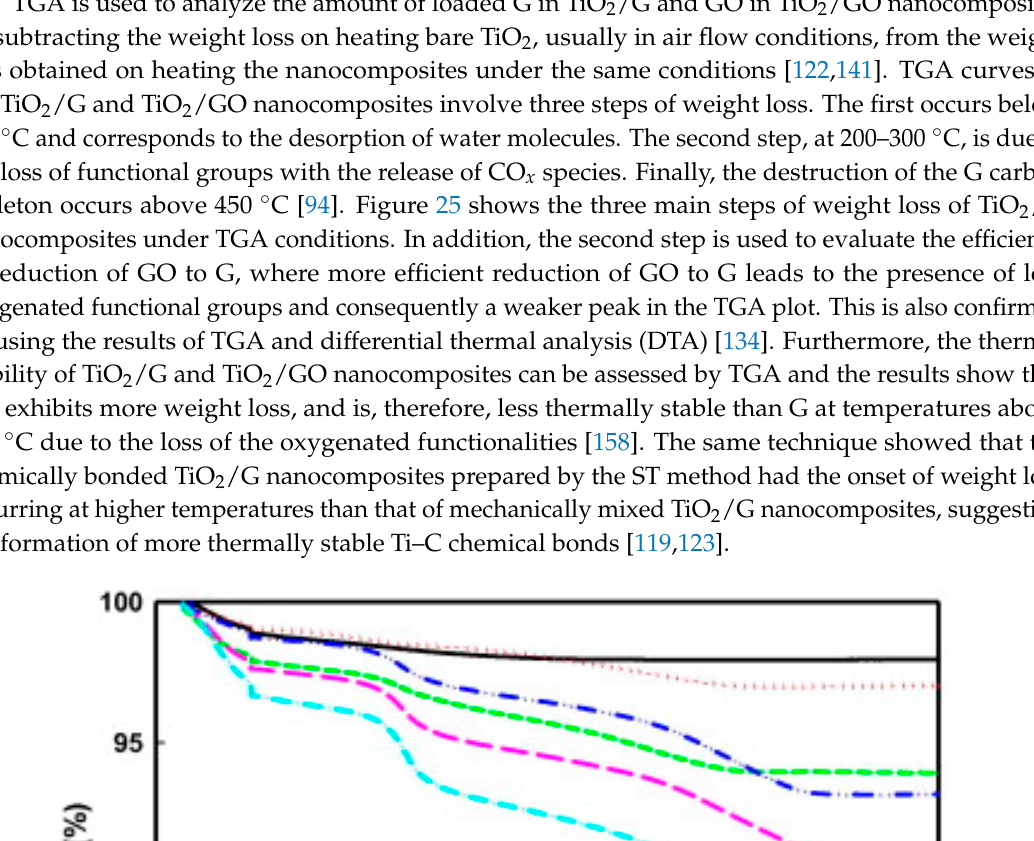
Figure 24. FT-IR spectra for GO and G prepared by reduction of GO using glucose (GOG), hydrazine (GOH) and ascorbic acid (GOV). Reprinted with permission from reference [158]. Copyright 2014 Elsevier.